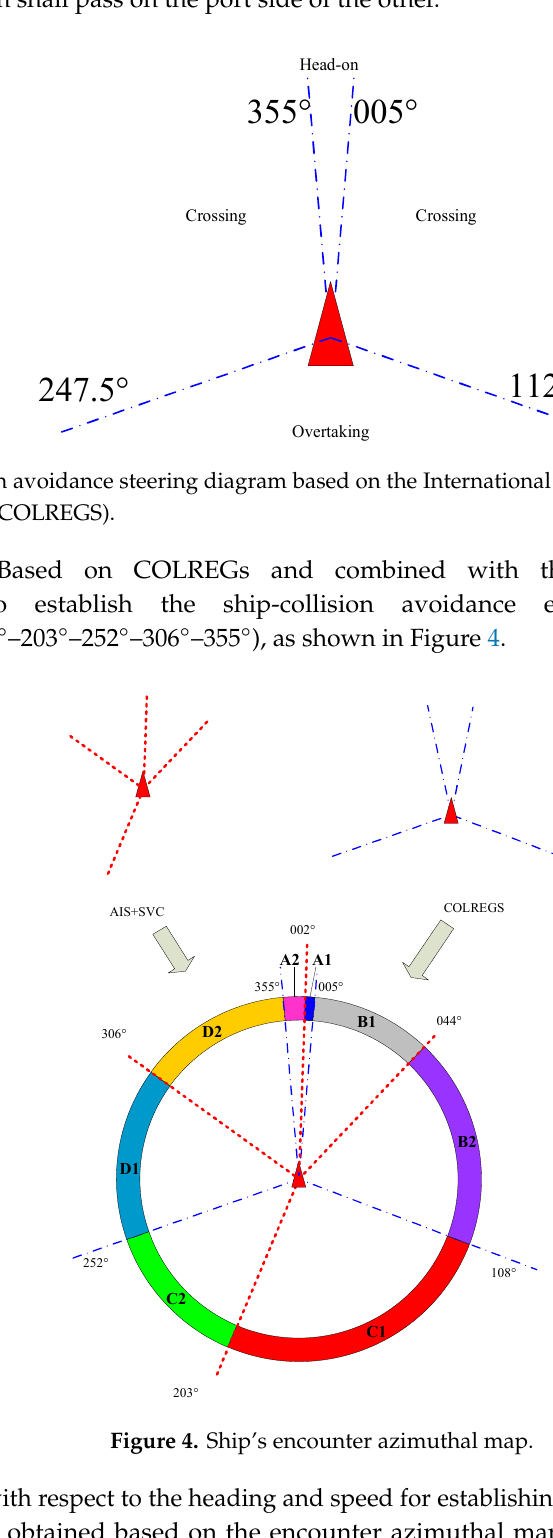
Figure 2. Radar-based collision avoidance steering diagram.